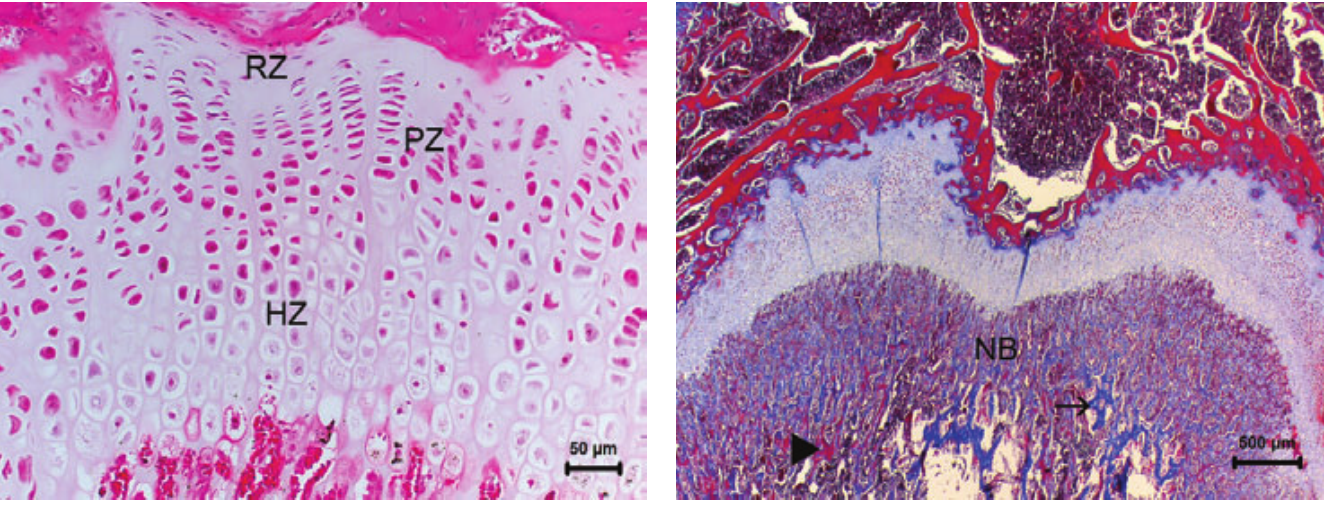
FIGURE 1 – H & E x 200. Photomicrograph of longitudinal section of distal growth plate of the rat femur after 21 days of laser irradiation. Resting zone (RZ), Proliferative zone (PZ), Hypertrophic zone (HZ).